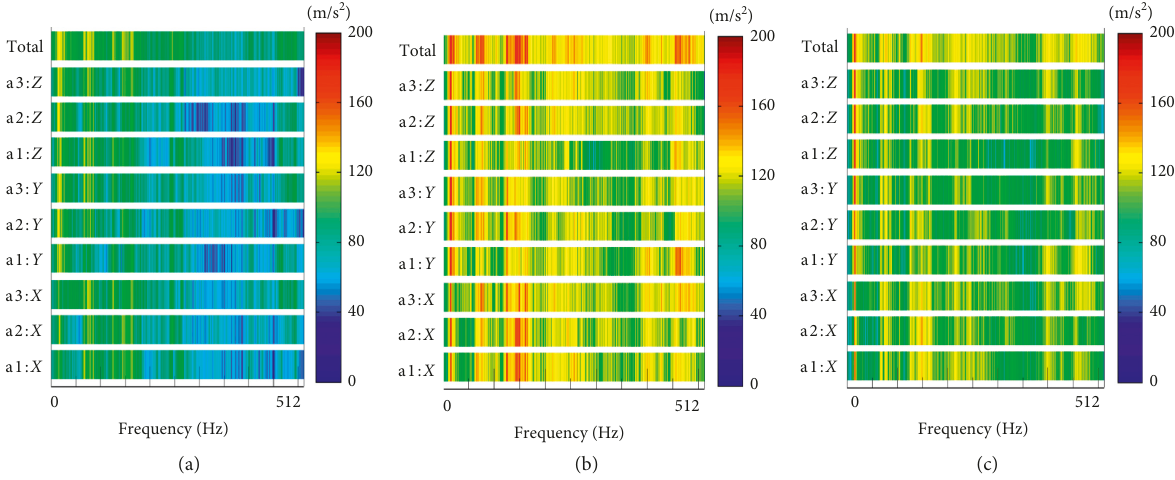
Figure 9: Frequency-domain vibration contribution analyses results calculated using M-2 and M-1. a direction. Total: O ( a )3( ω ) vibration response calculated in the Z direction. (a) 2s-4s M-2. (b) 10s-12s M-2. (c) 2s-14s